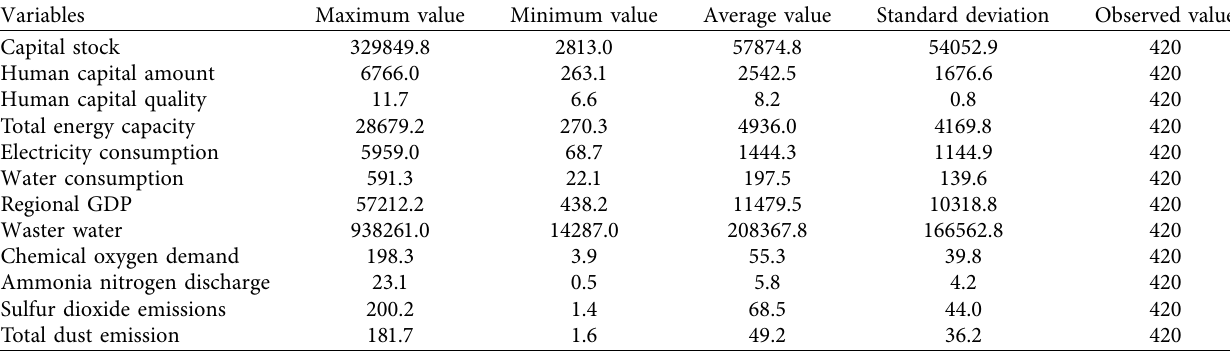
Table 2: Descriptive statistics of investment-ouput